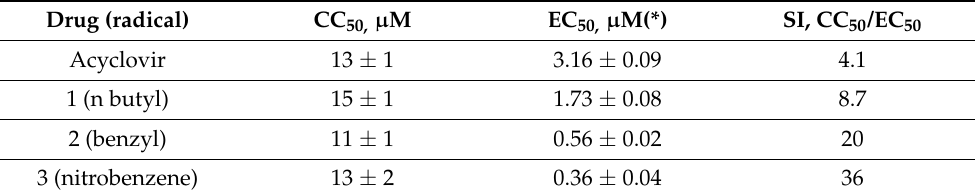
Table 3. Values of cell viability (CC50), antiviral activity (EC50) and selective index (SI) of acyclovir and 2-aminomethyl-3-hydroxy-1,4 naphthoquinones derivatives encapsulated in